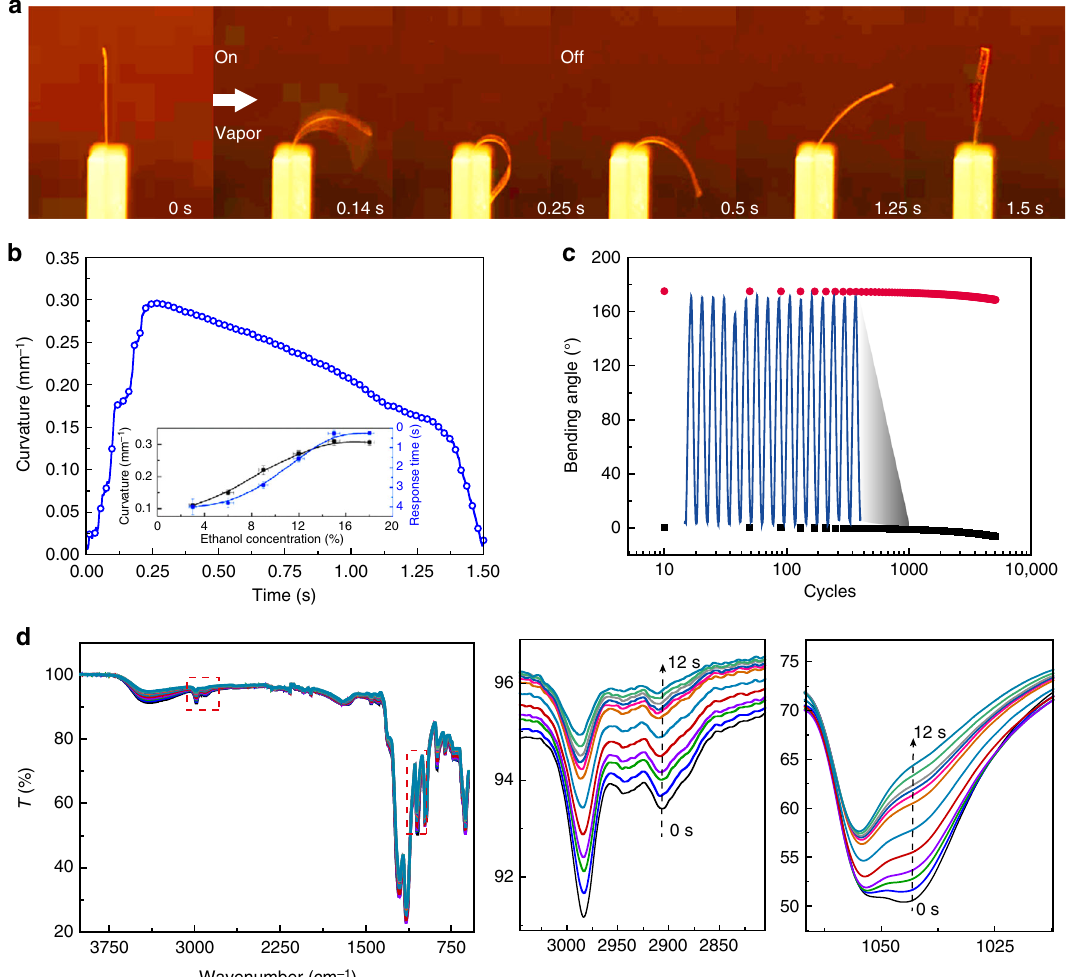
Fig. 2 Actuation performance of the single-layer membrane. a Adaptive actuation movement of a PFSA membrane (5 mm × 15 mm × 75 µ m) in response to ethanol vapor sorption and desorption (the vapor is from the left side of the PFSA membrane). b Plots of curvature against time (inset: a schematic of the curvature calculation). The insert image is the actuation curvatures and response time of a 75 μ m PFSA fi lm under different ethanol vapor concentrations. c Plots of the reversible deformation of the 75 µ m fi lm upon cyclic exposure to a 15% ethanol concentration vapor (8000 cycles without obvious fatigue). d Time-dependent ATR – infrared spectra of fi lm saturated by exposing in ethanol vapor for 10 s (bottom to top: 0 – 12 s after exposing in (Fig. 2d). Over time, the typical ethanol vibrations for – CH 3 and C – O stretching at 2910 cm -1 and 1040 cm -1 , respectively, became weak, suggesting that ethanol could be absorbed in varying amounts and desorption occurred rapidly.